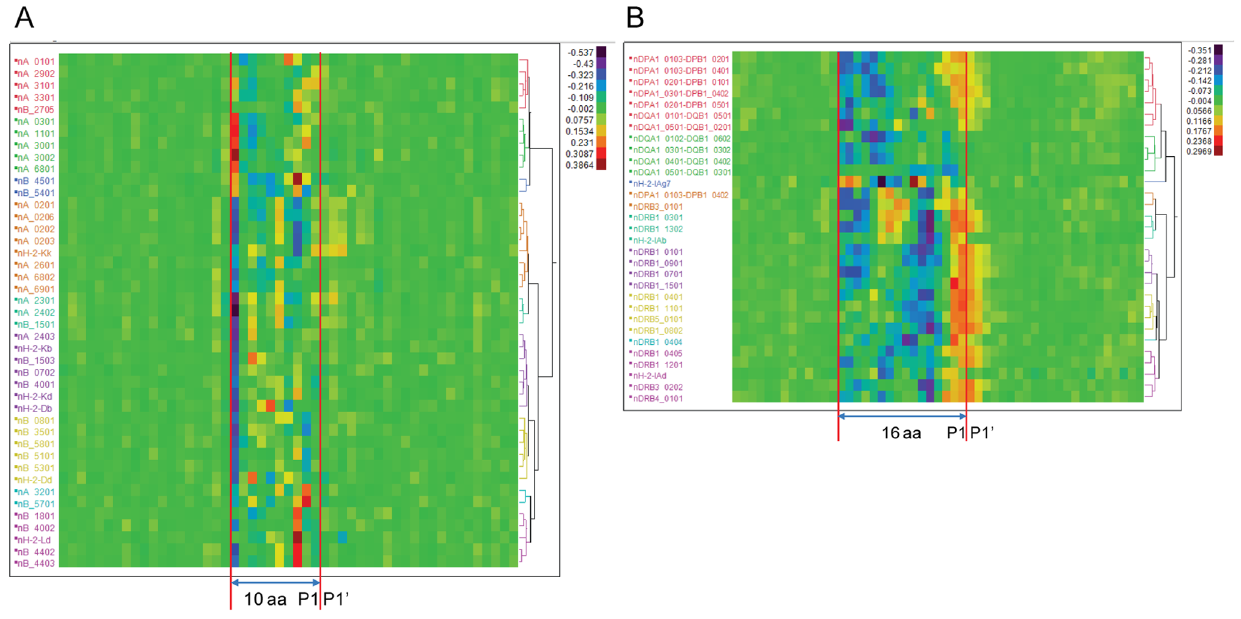
Figure 2. Heat diagrams of cross correlation of predicted MHC binding with predicted cathepsin L cleavage in tetanus toxin. The predicted binding affinity of sequential 9-mers (A: MHC-I) and 15-mers (B: MHC-II) for different human and murine MHC alleles is shown correlated with predicted cathepsin L cleavage sites. As the natural log of MHC binding affinity has been standardized to a zero mean and unit variance by allele within protein, the highest affinity has the lowest numerical value (blue on the thermometer scale). Human cathepsin L cleavage probability ranges from 0–1. The magnitude and sign of the correlation coefficient for each allele is indicated by the thermometer scale. The 95 th percentile confidence limits for non-significant correlations is 6 0.05. By convention, cleavage is designated as occurring at the P1-P1’ scissile bond; this position is marked. For cathepsin L and S the amino acid at position P2 has a strong tendency to be more hydrophobic than P1. Predicted MHC-I high affinity binding peptides align with their index positions at 10 amino acid positions proximal (toward N-terminus) of the P1P1’and MHC-II at 16 amino acids proximal of P1P1’. The corresponding plot for all 11 proteins is shown in Figure S3.1.